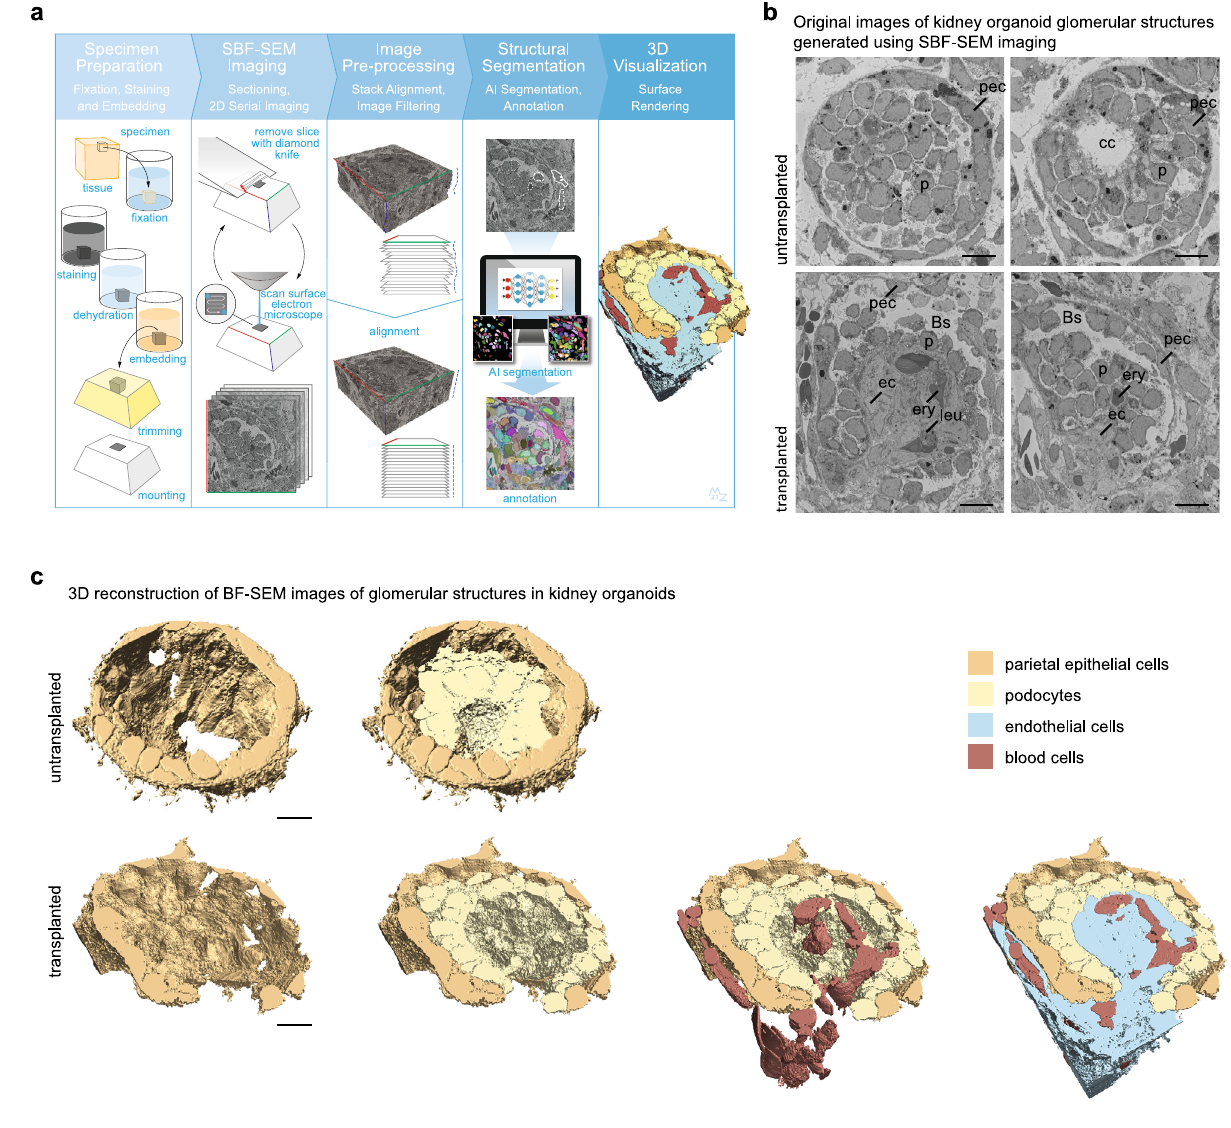
Fig. 5 SBF-SEM followed by 3D reconstruction enables analysis of the 3D organization of organoid glomerular structures and reveals maturation to capillary loop stage. a The SBF-SEM imaging work fl ow comprises fi ve steps. First the specimen is prepared for imaging by chemical fi xation, staining with heavy metals, dehydration and embedding in resin, after which it is prepared for imaging by trimming the block and mounting for SEM. SBF-SEM imaging is performed inside the microscope and consists of alternating sectioning and imaging steps, by which a stack of images through the specimen block is generated. Image pre-processing is performed by image alignment and fi ltering. Segmentation of cell structures, such as nucleus, mitochondria and endoplasmic reticulum was performed by Arti fi cial Intelligence methods followed by manual annotation of cell types. Visualization of images and movies is performed by surface rendering of segmented structures. b Images generated by SBF-SEM of glomerular structures in untransplanted (top) and transplanted (bottom) kidney organoids (iPSC-MAFB). For full Z-stacks, see Supplementary Movies 1, 2. Bs Bowman ’ s space, cc central cavity, ec endothelial cell, ery erythrocyte, leu leukocyte, p podocyte, pec parietal epithelial cell. Scale bar 10 µm. c 3D reconstruction of the SBF-SEM datasets in B and Supplementary Movies 1, 2. In the untransplanted glomerular structure (top) a layer of parietal epithelial-like cells (beige) is visible surrounding a cluster of podocytes (yellow) containing a central cavity. In the transplanted glomerular structure (bottom) a perfused capillary (endothelial cells in blue, blood cells in red) invades the glomerulus and forms a single loop inside the glomerulus. The podocytes (yellow) have reorganized around the capillary and the PECs (beige) have adopted a more fl attened phenotype. For 360° view of the 3D reconstructions, see Supplementary Movies 5, 6. Scale bar 10 µm. For SBF-SEM analysis, 2 transplanted organoids and 1 untransplanted organoid, all differentiated from iPSC-MAFB, were used to generate 4 datasets of untransplanted and 3 datasets of transplanted glomerular structures. 2 datasets (1 transplanted and 1 untransplanted) were used for the 3D visualization shown in ( c does not establish a gradient, supports EC proliferation, but fails to podocytes during embryonic development is essential for recruit- induce glomerular vascularization 54 . In our transplanted podo- ment, differentiation and maintenance of glomerular ECs 5,53 . Although it has been demonstrated that organoids in vitro cytes, we found upregulation of a gene set associated with VEGF produce VEGF 10 , either the levels produced or the concentration production (Supplementary Fig. 6A), and gene expression of VEGFA was clearly enhanced in podocytes compared to all other gradient within the organoid could be insuf fi cient. The addition of organoid cell clusters (Supplementary Fig. 5C) implying that the VEGF to organoid culture media, which increases VEGF level but